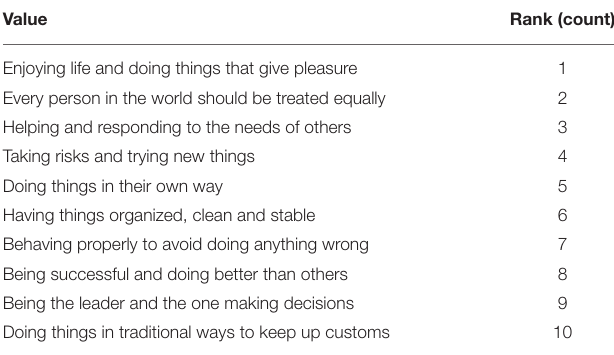
TABLE 3 | Count analysis rankings for general value statements in entire